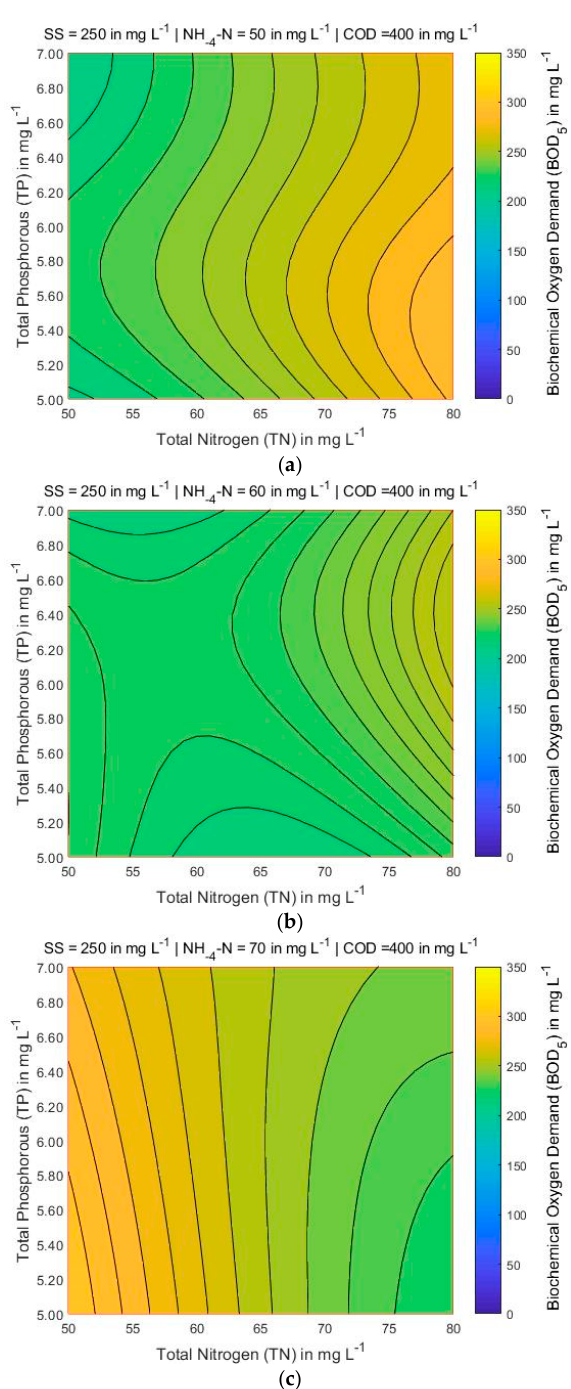
Figure 11. BOD 5 contour maps for three different values of NH 4 -N (in mg L − 1 ) while SS = 250 mg L − 1 and COD = 400 mg L − 1 are constant: ( a ) NH 4 -N = 50; ( b ) NH 4 -N = 60; and ( c ) NH 4 -N = 70.